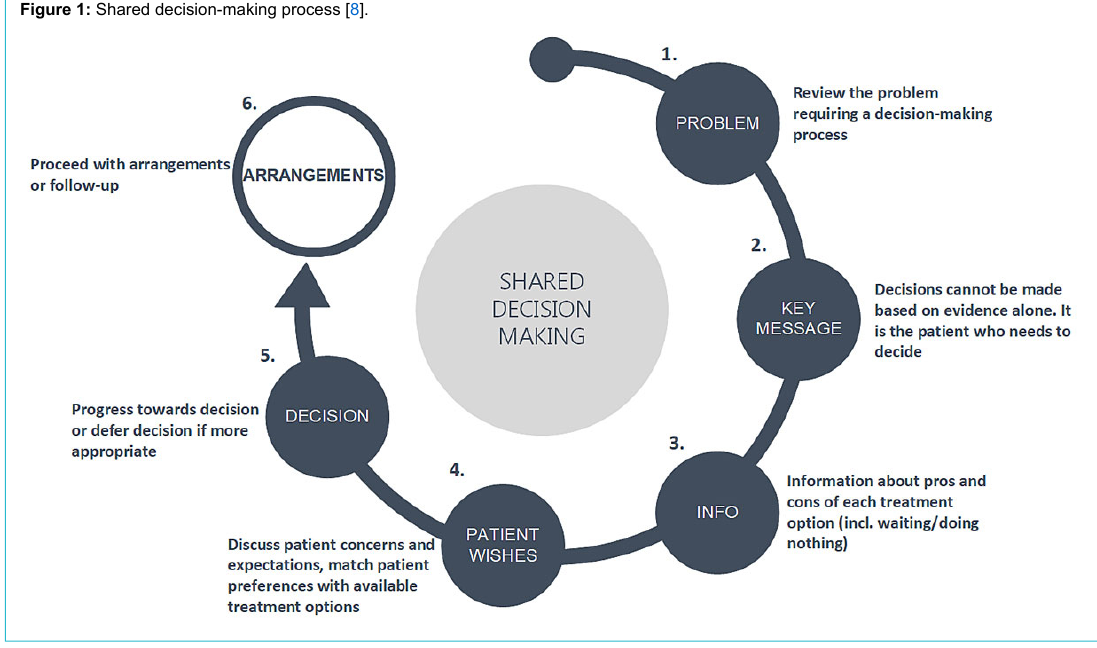
Figure 1: Shared decision-making process